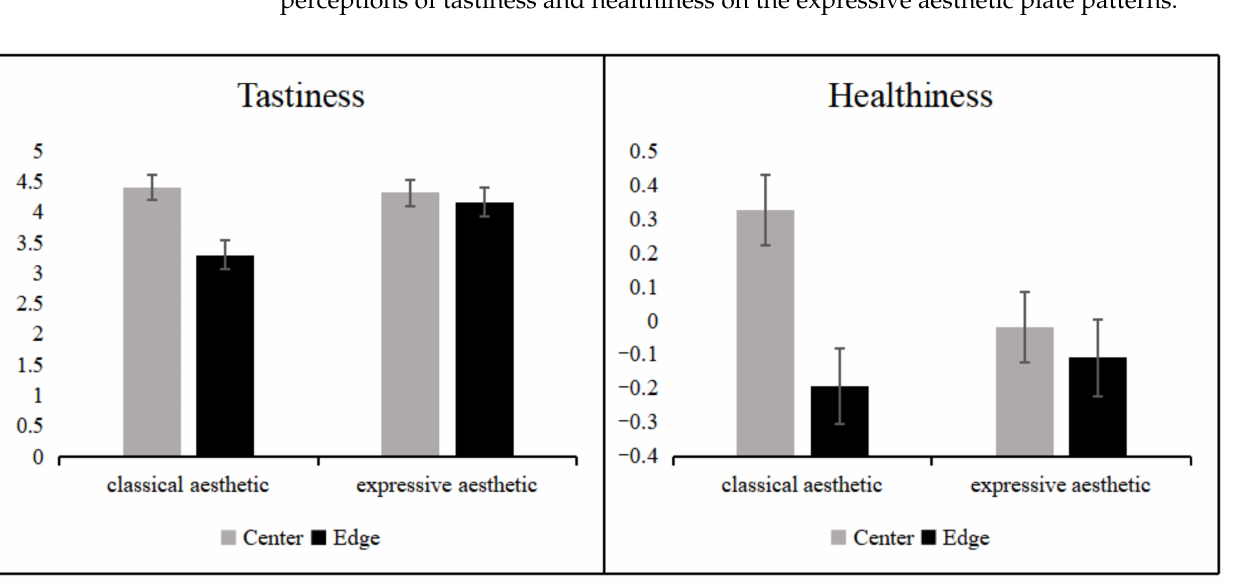
Figure 10. Tastiness ( left ) and healthiness ( right ) for differently patterned plates with different placements of food. Error lines represent 95% confidence